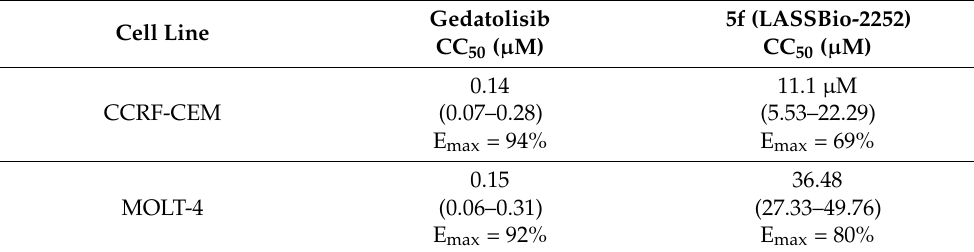
Table 4. CC 50 values calculated from the 48 h MTT cell viability